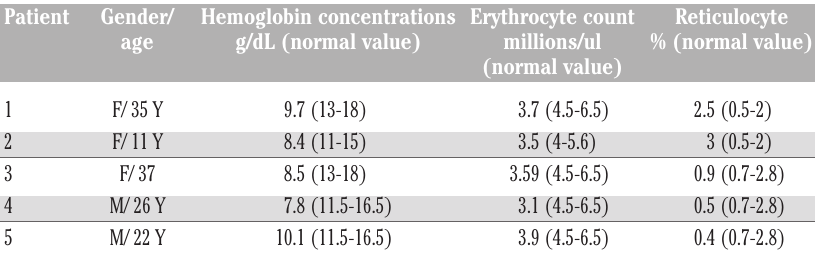
Table 1. Hematologic data for the 5 HCV-infected sickle-cell anemia patient (n=5).